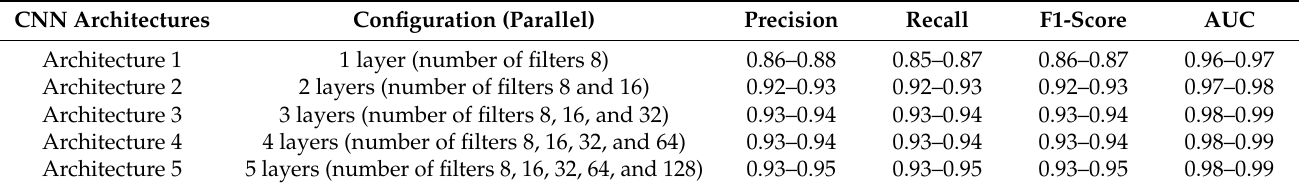
Table 3. The performance results for classifying each blood pressure level of test data using the proposed concatenated CNN